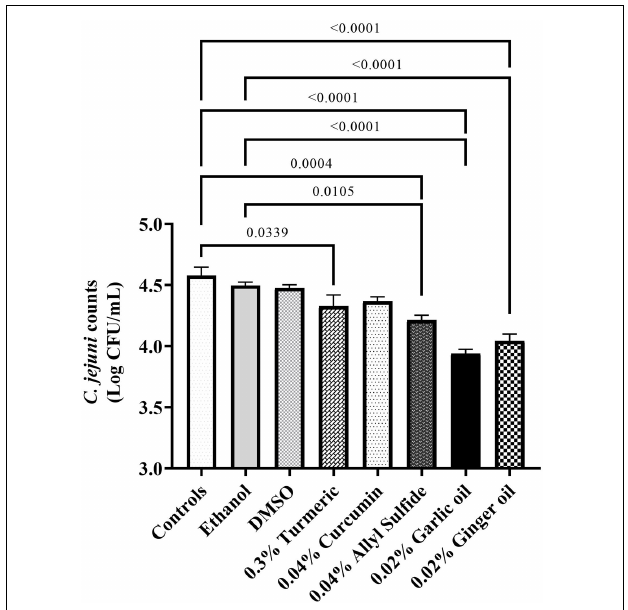
FIGURE 5 | Effect of dimethyl-sulfoxide (DMSO), ethanol, turmeric, curcumin, allyl sulfide, garlic oil, and ginger oil at SIC dose on the attachment of C. jejuni wild-type S-8 to ATCC CRL-1590 chicken embryo cells. Results are averages of two independent experiments, each containing triplicate samples (mean and SEM). The estimated p -values < 0.05 are included above the